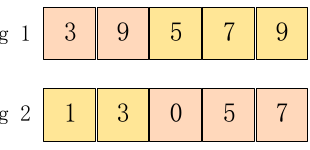
Figure 5. Crossover of the parking chromosomes.